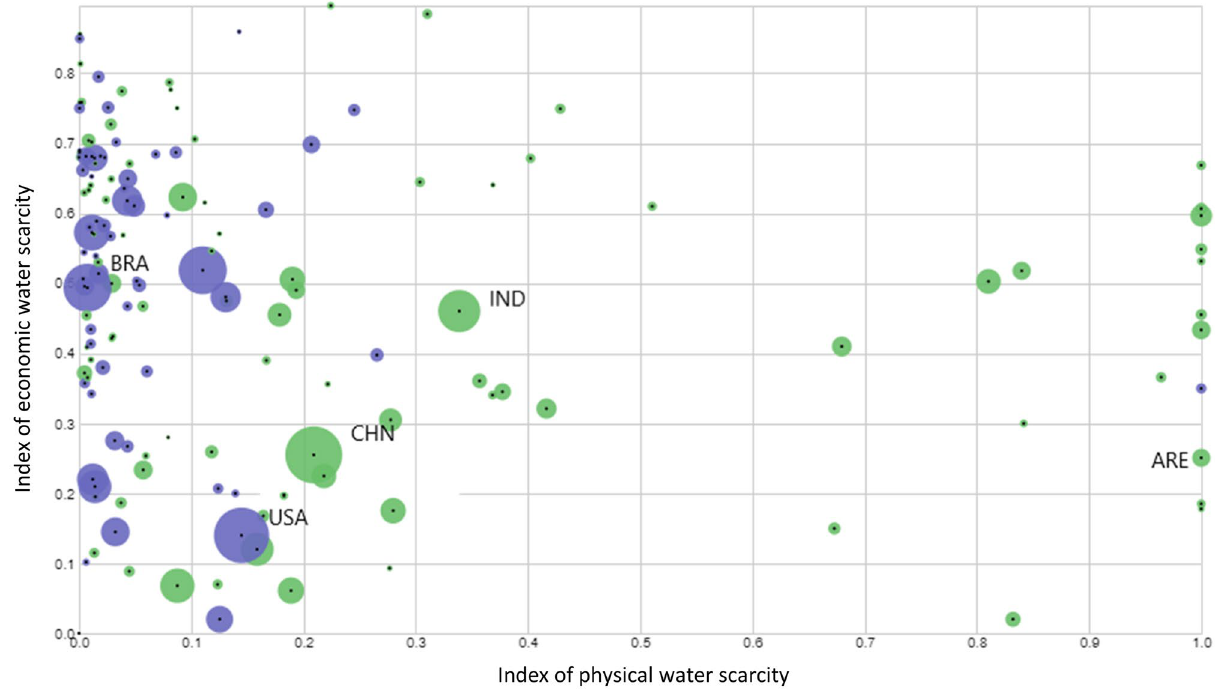
Figure 2. Physical water scarcity (hydrological pressure) and economic water scarcity (1 − IWRM) for 149 countries (2017). The size of the point is proportional to the total volumes of VW involved in both export and import for that country (m3). Green points indicate net importer countries (having VW import associated to food higher than export), while violet points indicate net exporter countries (having VW export higher than import). The ISO codes correspond to the following countries. BRA Brazil. USA United States of America. CHN China. IND: India. ARE United Arab